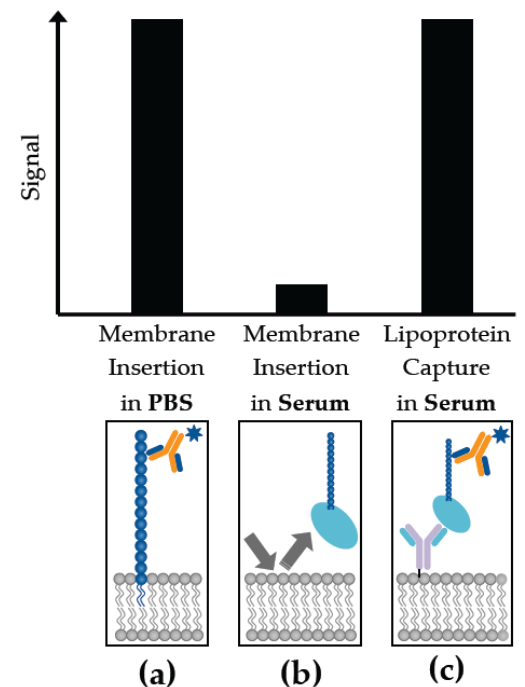
Figure 3. A comparison of the sensitivity of membrane insertion and lipoprotein capture technologies for the measurement of amphiphilic biomarkers based on the medium of presentation (serum vs. buffer). Biomarkers that are readily detected in ( a ) phosphate buffered saline (PBS) can be poorly observed in ( b ) serum when utilizing a membrane insertion assay strategy, because of the uptake of these signatures by host serum carrier molecules. This signal can be recovered if ( c ) lipoproteins are incorporated in the assay format, exploiting the host pathogen interaction for maximal sensitivity of